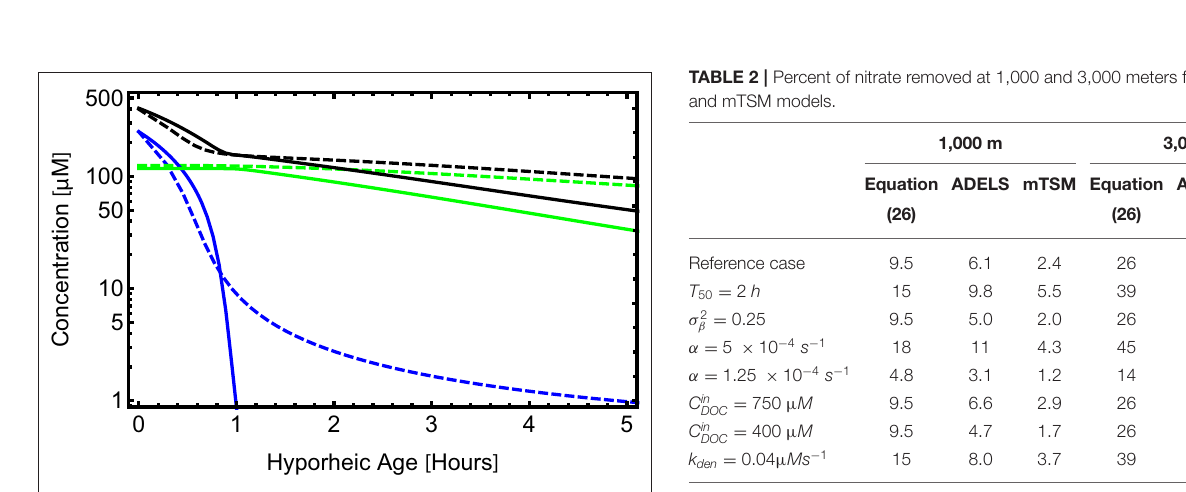
FIGURE 5 | Hyporheic zone concentration for the ADELS model (solid curves) and the mTSM (dashed curves). The blue curve represents oxygen concentration, the green curve nitrate, and the black curve DOC. The x -axis is hyporheic age in the ADELS model and a characteristic time related to the exchange coefficient in the mTSM. Note that oxygen concentrations in the mTSM model do not drop below the inhibition constant for denitrification, thus partially inhibiting denitrification in the mTSM model.